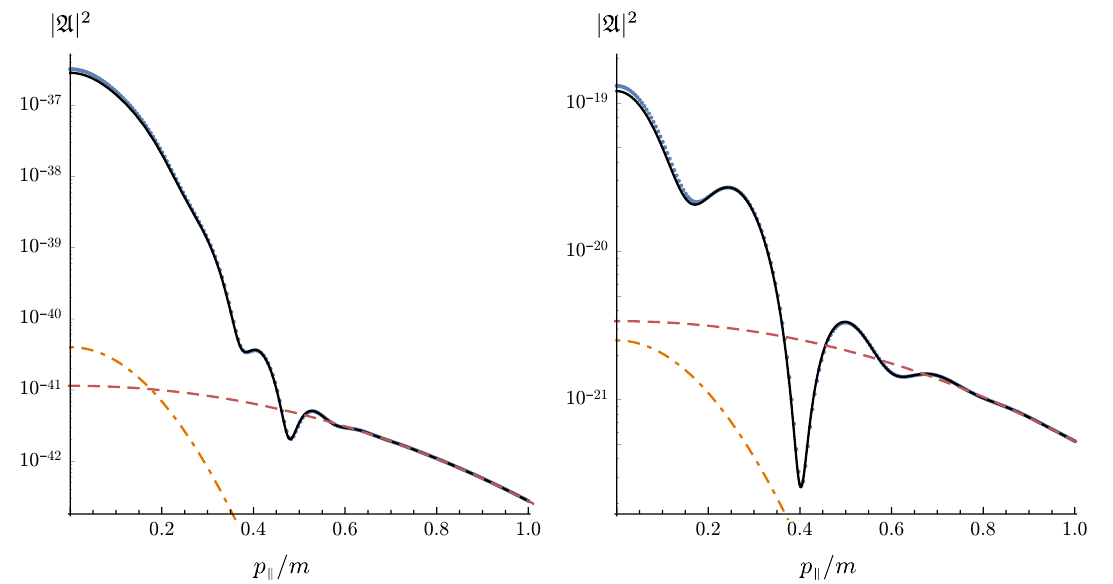
Figure 1 . Logarithmic plots of the pair production probability as a function of the longitudinal momentum p =m , with p = 0, for the double Sauter pulse in (1.2) with the parameters E = k ? 0 : 033 E crit and (cid:13) = 2 : 2 for the left plot, and E = 0 : 066 E crit and (cid:13) = 2 : 43 for the right plot, and (cid:13) slow = 0 : 2 and " = 10 (cid:0) 3 in both cases. The solid black curves show the (cid:12)rst order result j A 0 ( p ) + " A 1 ( p ) j 2 , where A 0 (cid:25) (cid:0) (cid:12) (cid:3) is obtained from (4.20) and A 1 is obtained from (4.28) (which gives a slightly better approximation than (4.29)). The blue dots correspond to the numerical solution of the Riccati equation, see section 6. The red dashed curves give the result for the strong (cid:12)eld alone, and the orange dot-dashed curves correspond to weak (cid:12)eld alone. The value of (cid:13) is chosen such that the dynamically assisted probability is much larger than the ones with either the strong or the weak (cid:12)eld alone (the weak/strong (cid:12)eld drops out for low/high (cid:13) ). The spectrum is symmetric around p